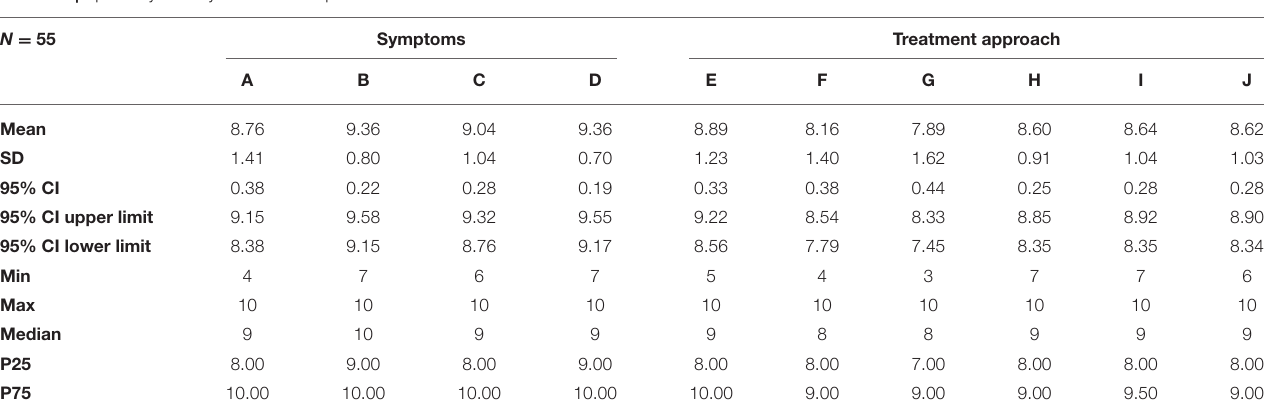
TABLE 2 | Spasticity-Plus syndrome concept. N = 55 Symptoms Treatment